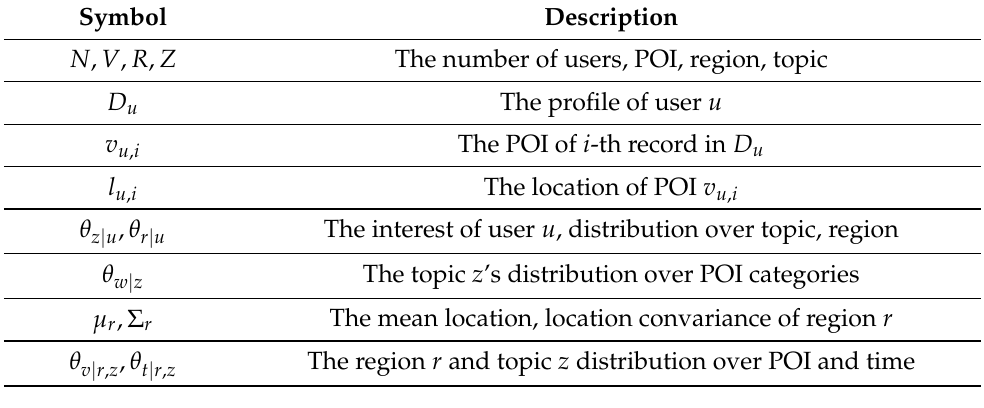
Table 1. Notations of parameters.